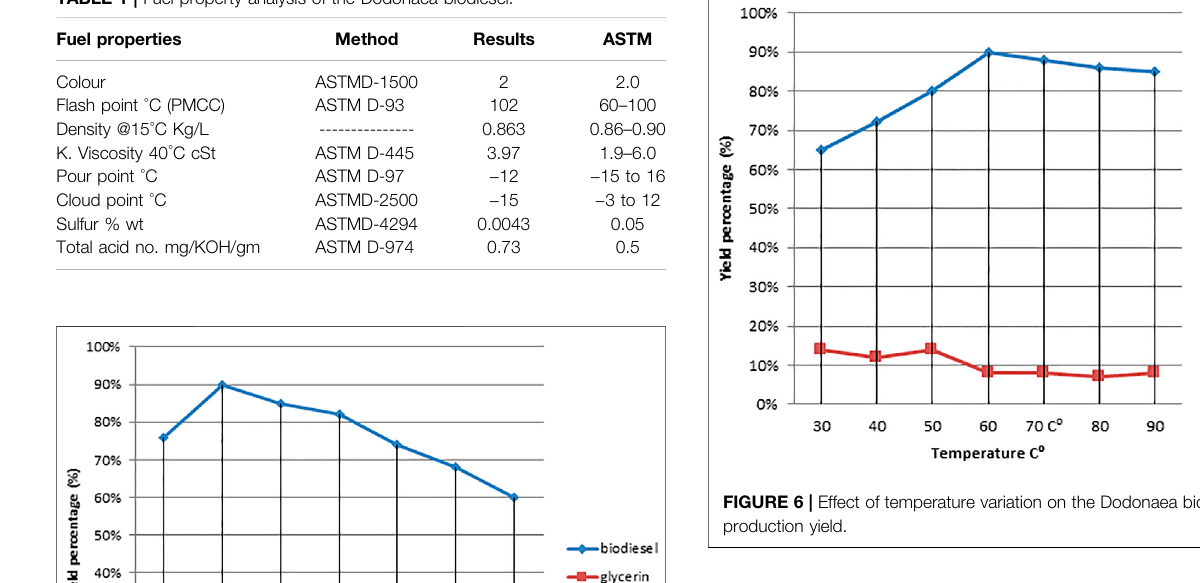
TABLE 1 | Fuel property analysis of the Dodonaea biodiesel.